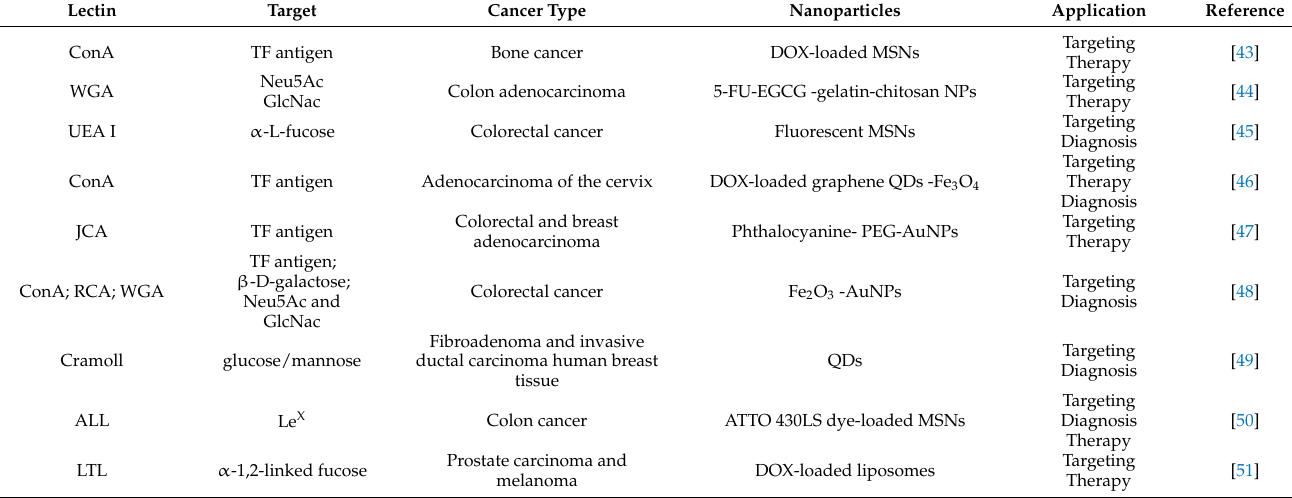
Table 1. Nanoparticles (NPs) functionalized with lectin targeting aberrant cancer-associated glycans. Abbreviations: Jacalin of Artocarpus integrifolia (JCA); Ulex europaeus Agglutinin-1 (UEA1); Cratylia mollis seeds lectin (Cramoll); Aleuria aurantia lectin (ALL); Ricinus communis agglutinin (RCA); Lotus tetragonolobus lectin (LTL); 5-fluorouracil (5-FU); ( − )-epigallocatechin- 3-gallate (EGCG); quantum dots (QDs); polyethylene glycol (PEG); gold nanoparticles